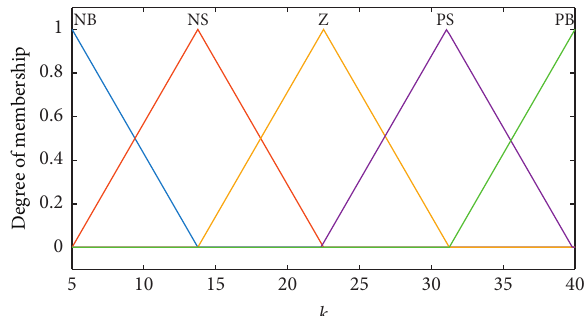
Figure 8: Membership function of approach law parameter k .